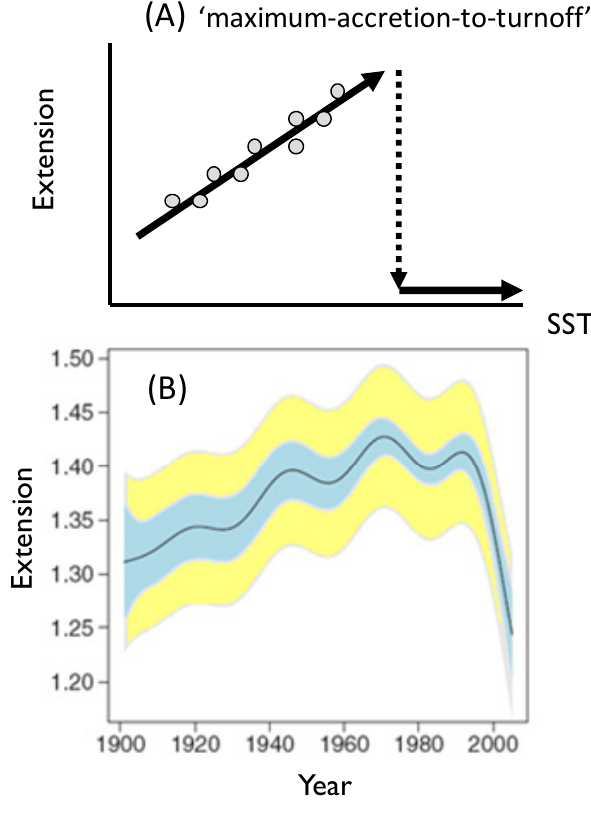
Fig. 8. (A) Schematic representation of the “maximum-accretion- to-turnoff” paradox, which sees coral reefs (and individual corals) extending at their maximum rate just prior to the point at which they cease net accretion. (B) Partial-effects plot showing the varia- tion of linear extension (cmyr − 1 ) in massive Porites colonies on the GBR over time (1900–2005), which highlights the 13.3% decline since 1990 (adapted from De’ath et al., 2009). Blue bands indicate 95% confidence intervals for comparison between years, and yel- low bands indicate 95% confidence intervals for the predicted value for any given